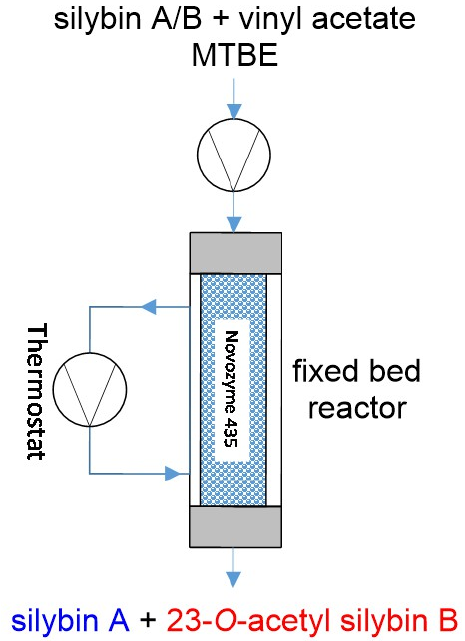
Figure 5. Schematic diagram of the flow chemistry setup.